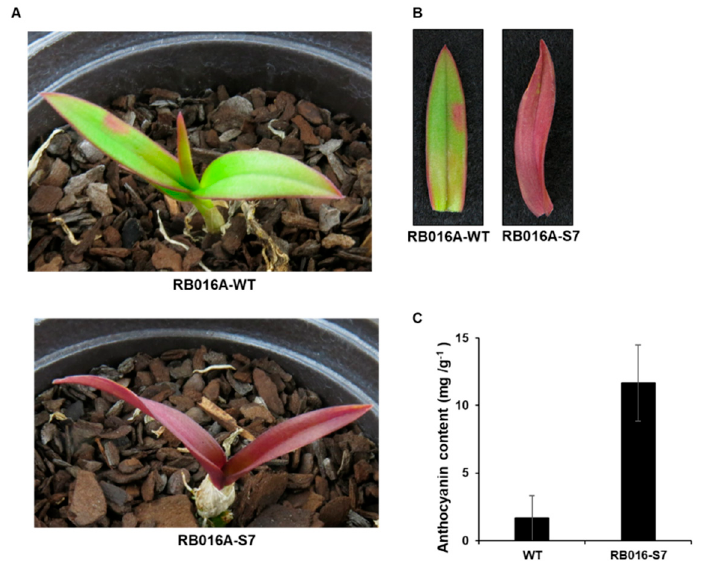
Figure 1. Images of Dendrobium bigibbum and the anthocyanin contents in the leaves. ( A ) Morphological phenotypes of typical wild type (WT) and RB016-S7 mutant D. bigibbum plants. ( B ) Relative anthocyanin contents in the WT and RB016-S7 mutant. Error bars represent standard deviations ( n = 3). The experiment was repeated three times with similar results. ( C ) The number of up- and downregulated differentially expressed genes (DEGs) in the WT 3 versus RB016-S7 mutant comparison. Table 1. Summary of RNA sequencing and de novo transcriptome assembly